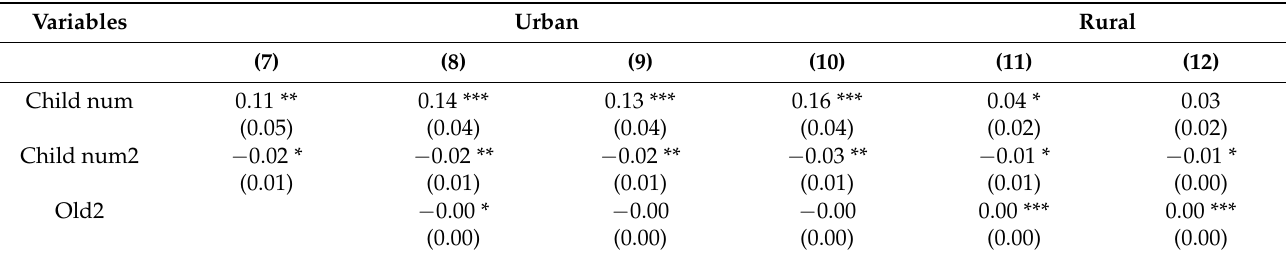
Table 10. Heterogeneity test: urban–rural heterogeneity (marginal